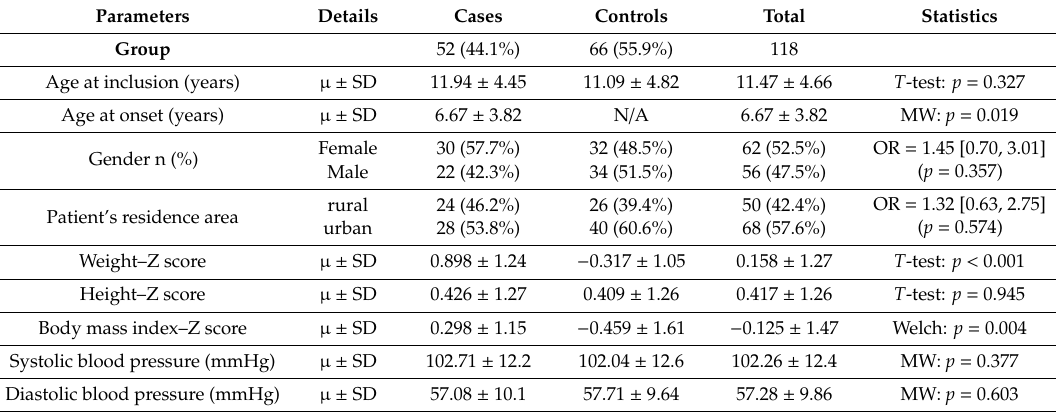
Table 1. Comparative demographic and anthropometric description of the two